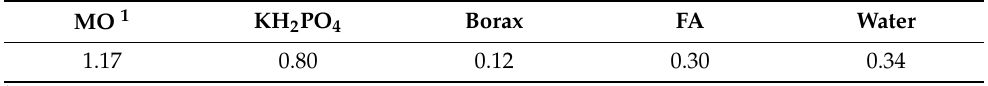
Table 2. Mix proportion of magnesium phosphate cement (MPC) (g/cm 3 ).